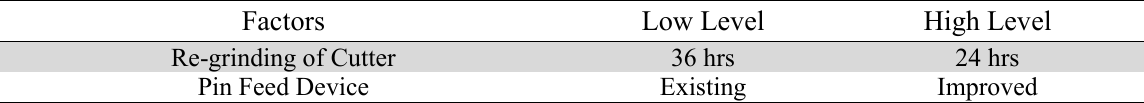
Vital Causes of Pin Length Variation